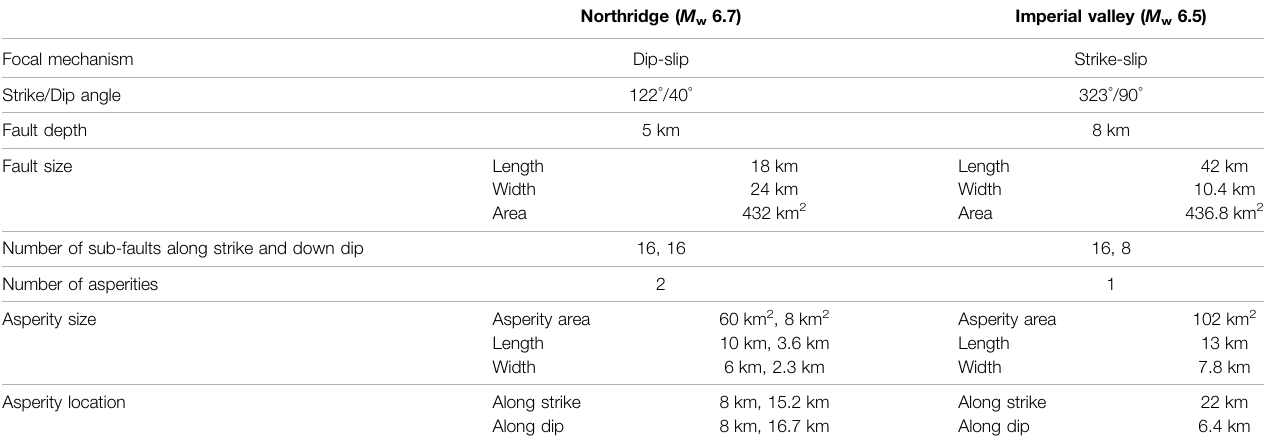
TABLE 2 | Source parameters used in the F-K method ground motion